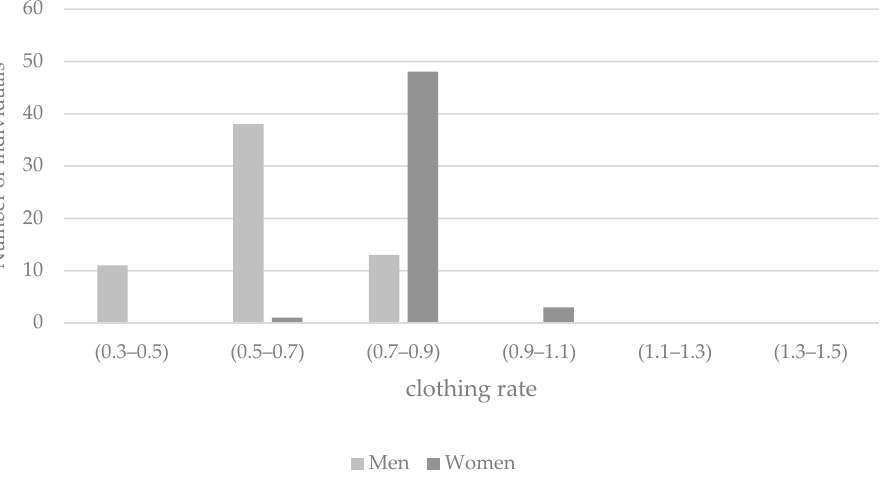
Figure 10. In hot seasons, people adjust their thermal state by various behaviors, such as removing a layer of